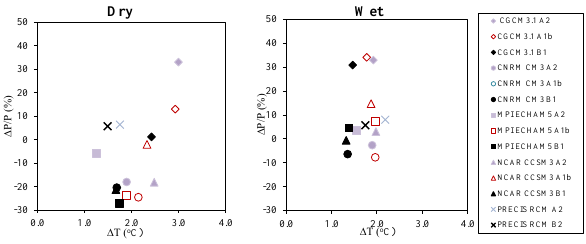
Fig. 4a. Projected changes in seasonal temperature and precipita- tion for all climate models (GCM/RCM) and GHGES for the period